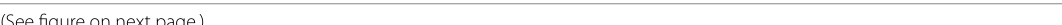
NC normal cataract, DC diabetic cataract a For patients with the glucose over 8.3 mmo/L, alimentary control, sports and drugs regulation were taken to modulate the glucose less than 8.3 mmol/L for further cataract